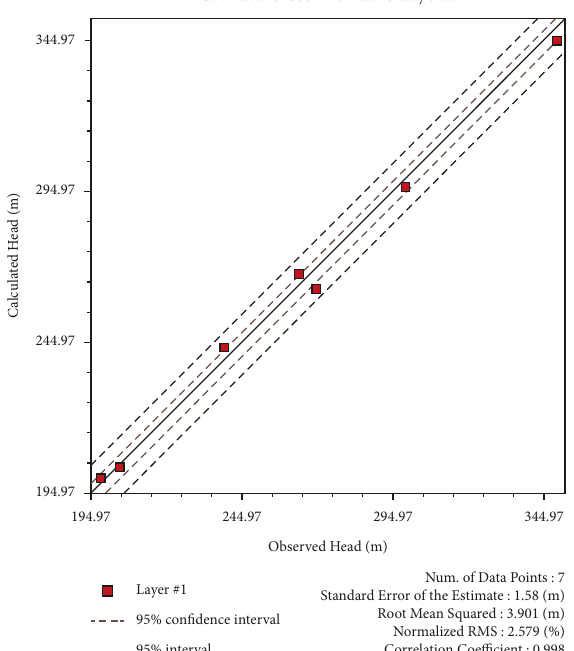
Figure 6: Fitting diagram of calculated water level and measured water